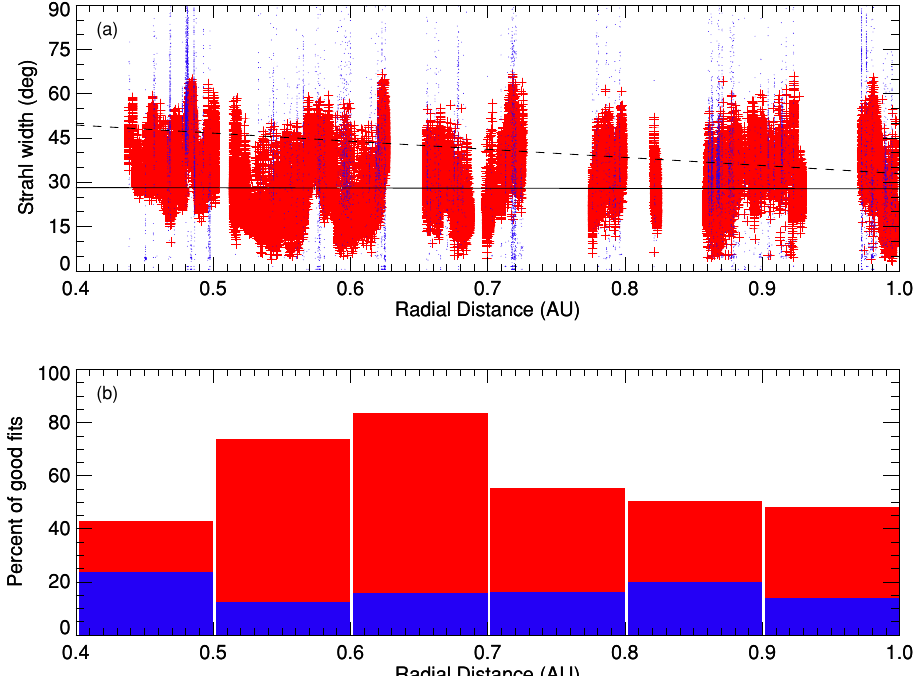
Figure 5. Characteristics and occurrence rates for anti-sunward strahl beams and sunward deficits as a function of radial distance from the Sun. The format is the same as for Figure 3, but the horizontal axis now shows the radial distance at which each sample was taken. ( a ) Scatter plots of the pitch angle width of the strahl (red points) and deficits (blue points) as a function of radial distance; ( b ) Occurrence rate histograms for the strahl (red) and deficit (blue) samples in 0.1 AU wide bins. The data is plotted as a percentage of the total number of good fits to samples taken in the relevant radial distance bins. Note that the height of the blue bars has been increased by a factor of 3 to aid